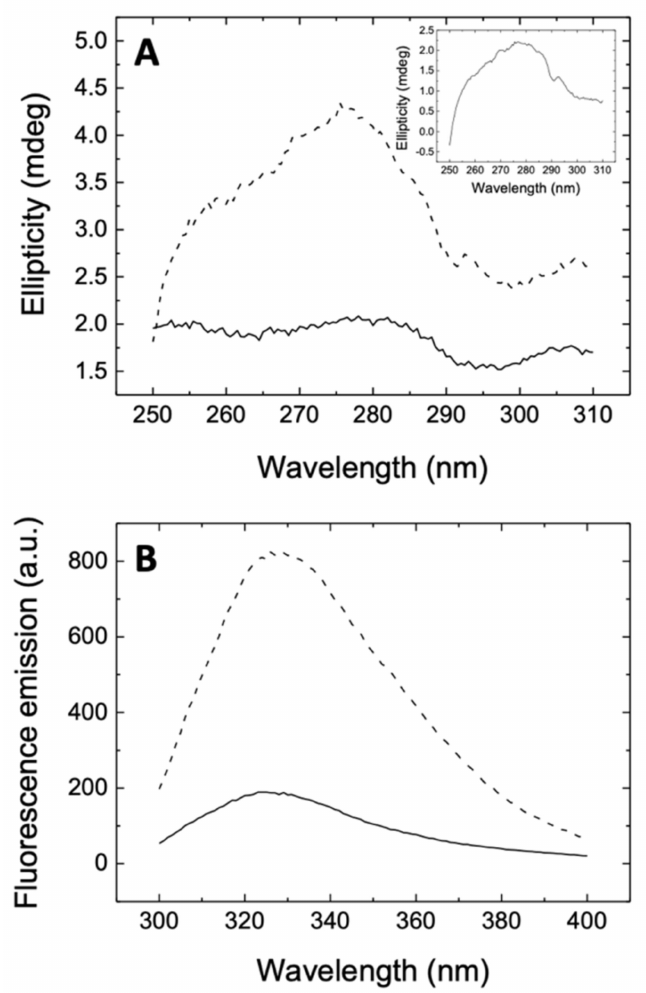
Figure 2. ( A ) Near-UV CD spectrum of the 3CLpro-rutin complex (continuous line) and addition of individual spectra of 3CLpro and rutin (dashed line), recorded at 10 µ M protein concentration and 100 µ M rutin concentration. Inset: Near-UV spectrum of 3CLpro. The non-equivalence of the spectrum of the complex and the addition of the spectra of free species is the result of the interaction. ( B ) Fluorescence emission spectrum (in arbitrary units, a.u.) of 3CLpro-rutin complex (continuous line) and addition of individual spectra of 3CLpro and rutin (dashed line), recorded at 2 µ M protein concentration and 100 µ M rutin concentration. Rutin showed negligible fluorescence emission; therefore, the dashed line also corresponds to the emission spectrum of